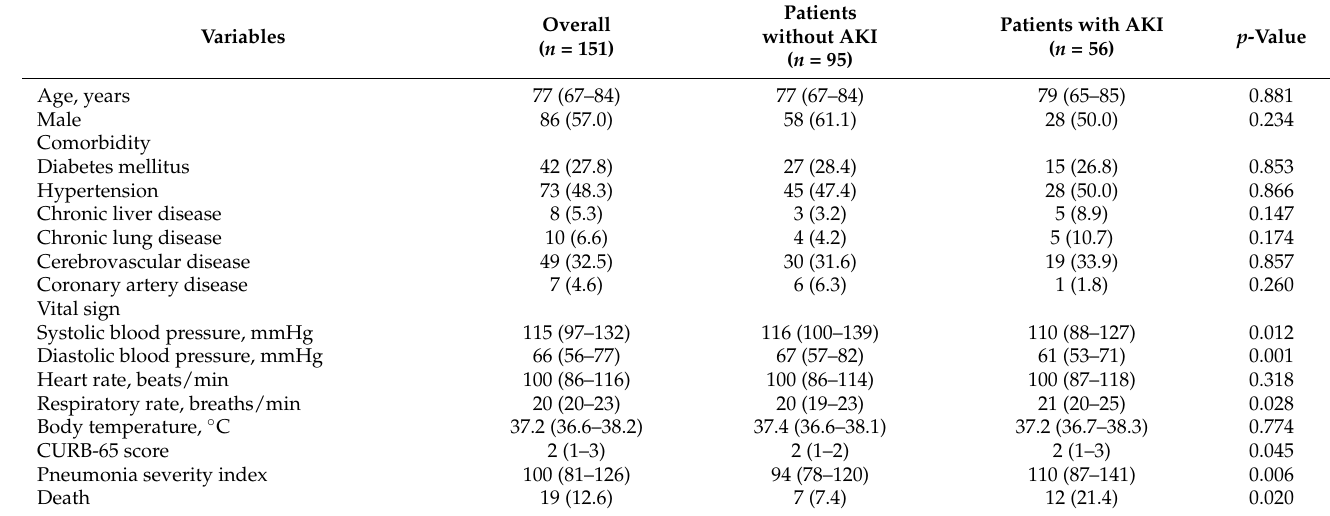
Table 1. Demographic and clinical characteristics of the included patients with